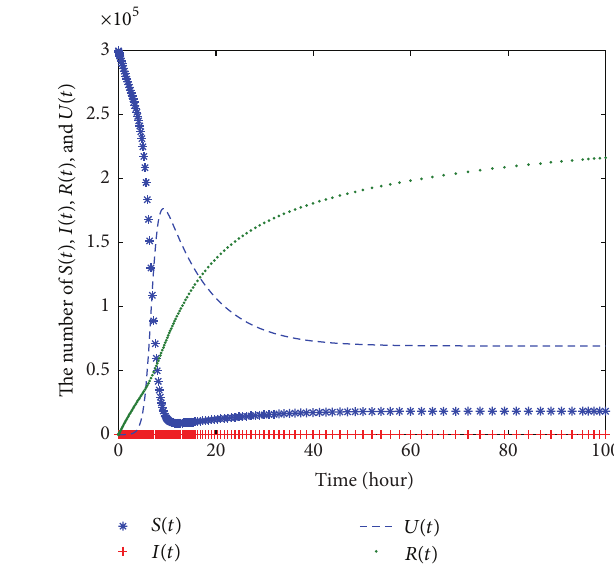
Figure 22: Benign worm infection state.